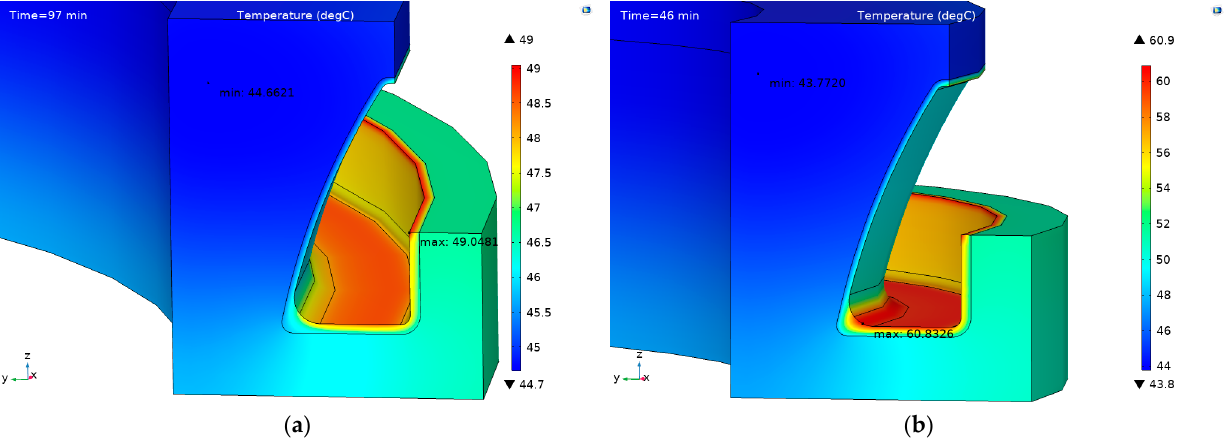
Figure 7. Temperature distribution plot in the part and the mould at the end of dwell phase before the cooling ramp for the curing cycle at ( a ) 60 °C and ( b ) at 100 °C.